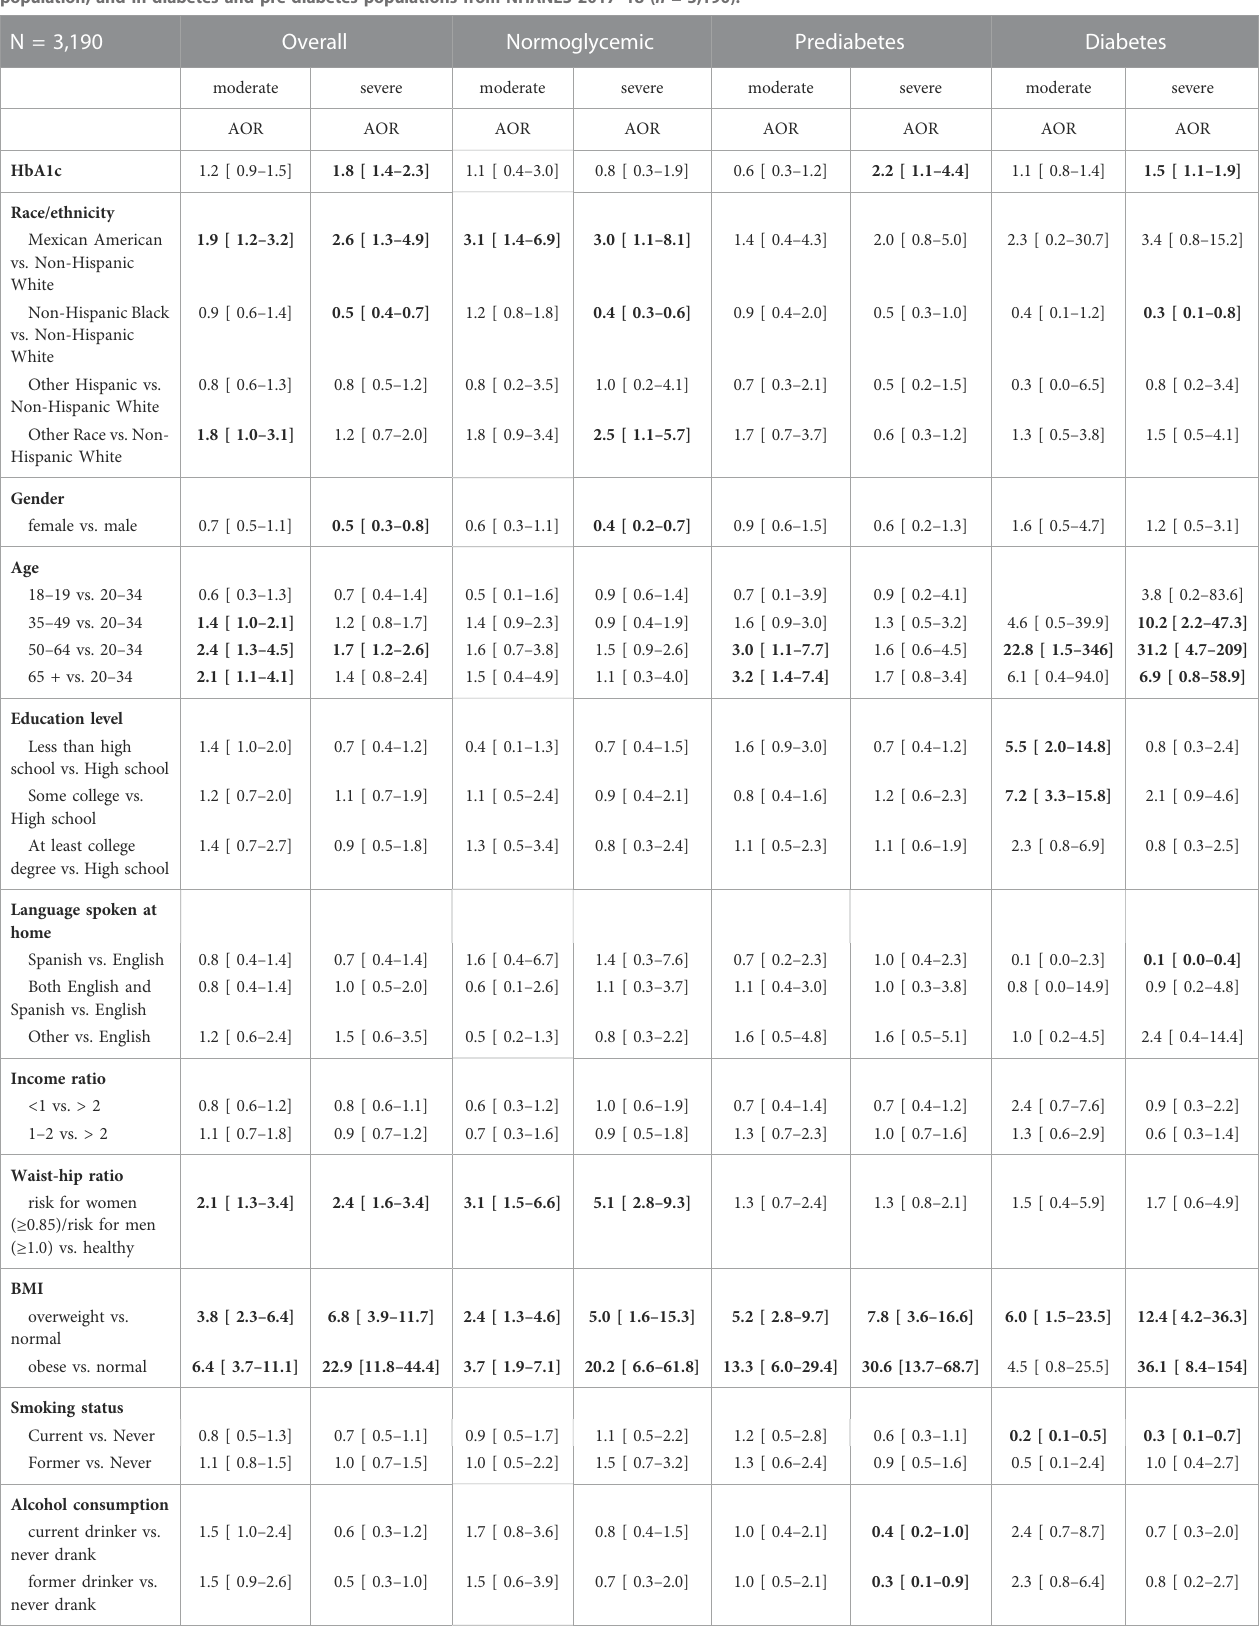
TABLE 2 Adjusted odds ratio (AOR) and 95% con fi dence interval for factors associated with NAFLD severity (Reference population of normal/mild) in the total population, and in diabetes and pre-diabetes populations from NHANES 2017 – 18 ( n = 3,190). N =